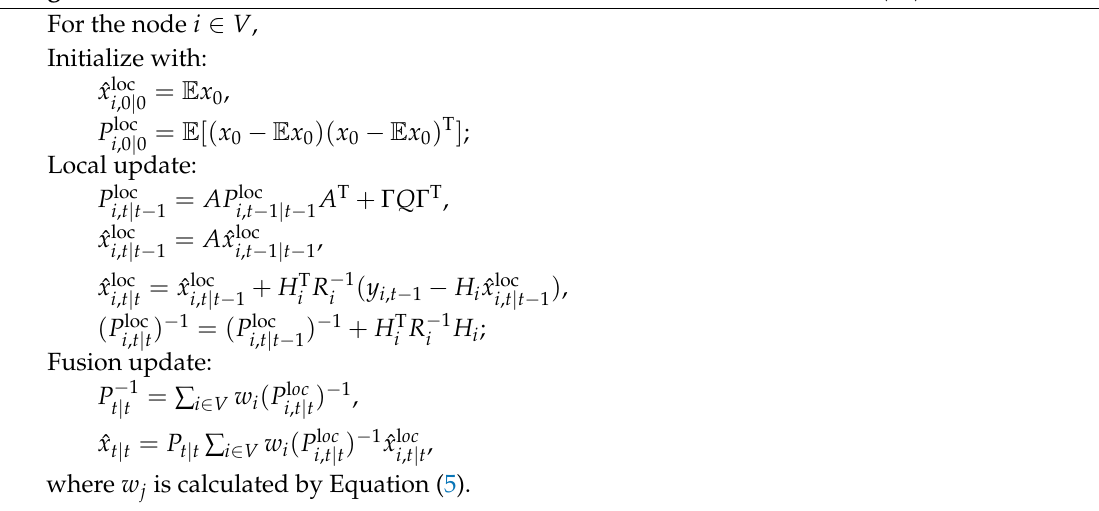
Algorithm 2: A centralized Kalman filter based on the covariance intersection (CI) method.